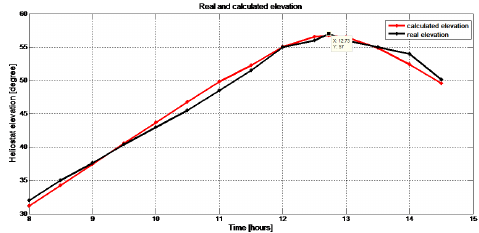
Fig. 10. Image of the sunspot on the target (azimuth test)